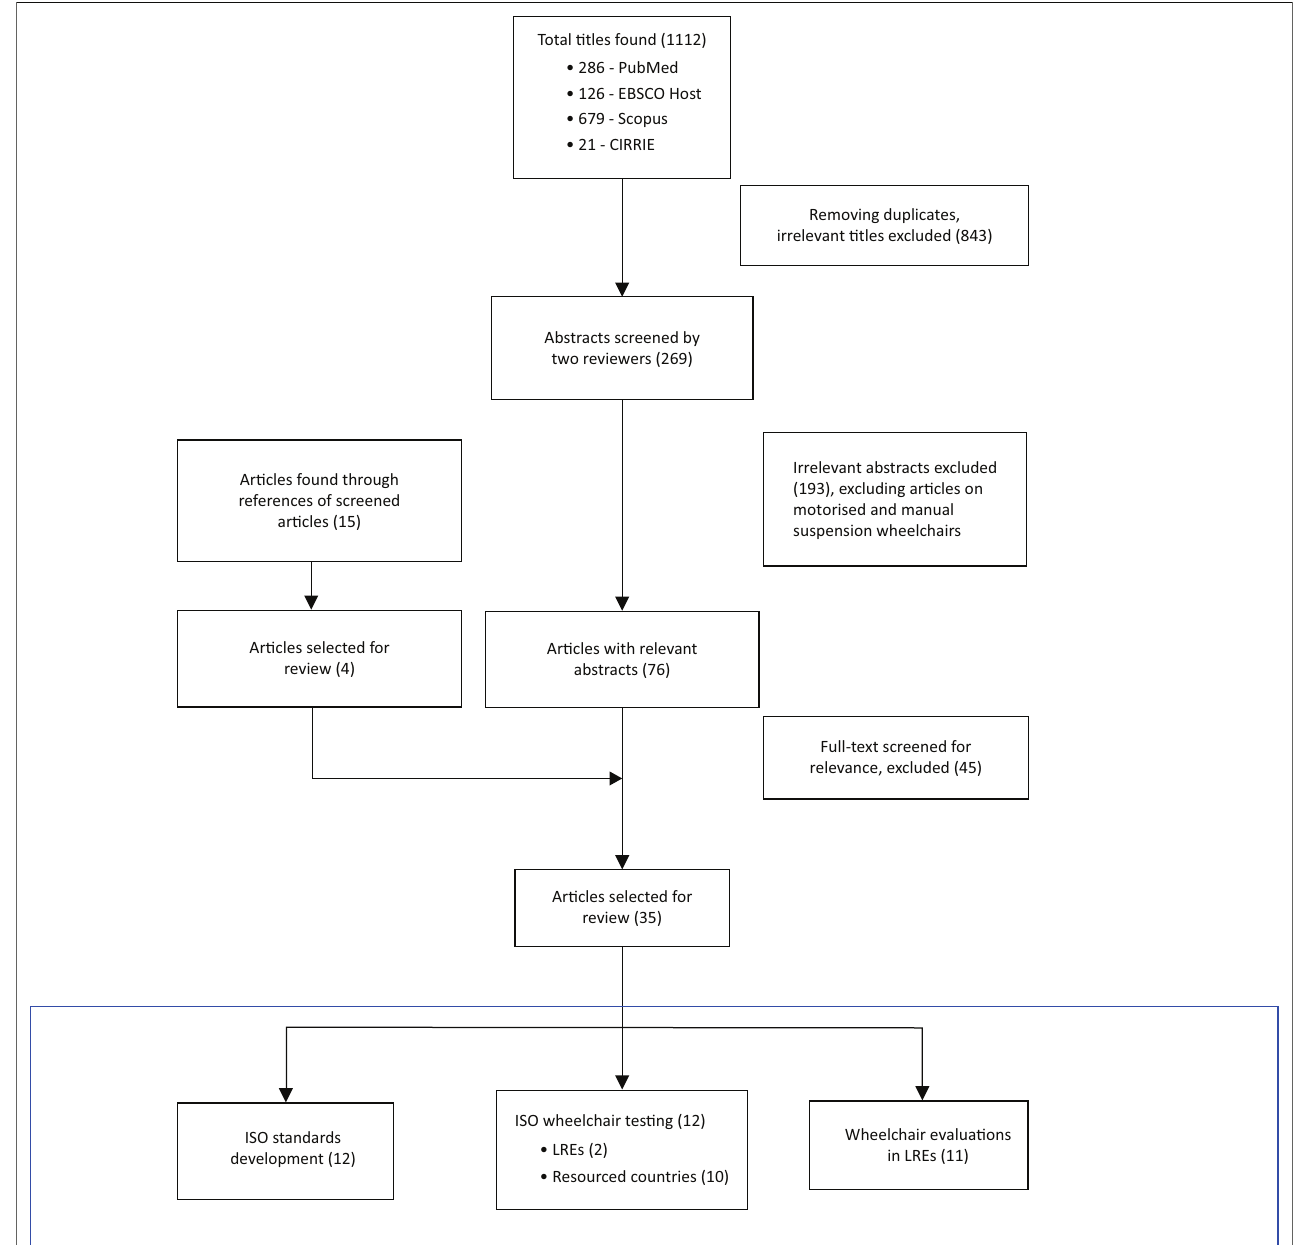
FIGURE 2: Flowchart of article selection process for